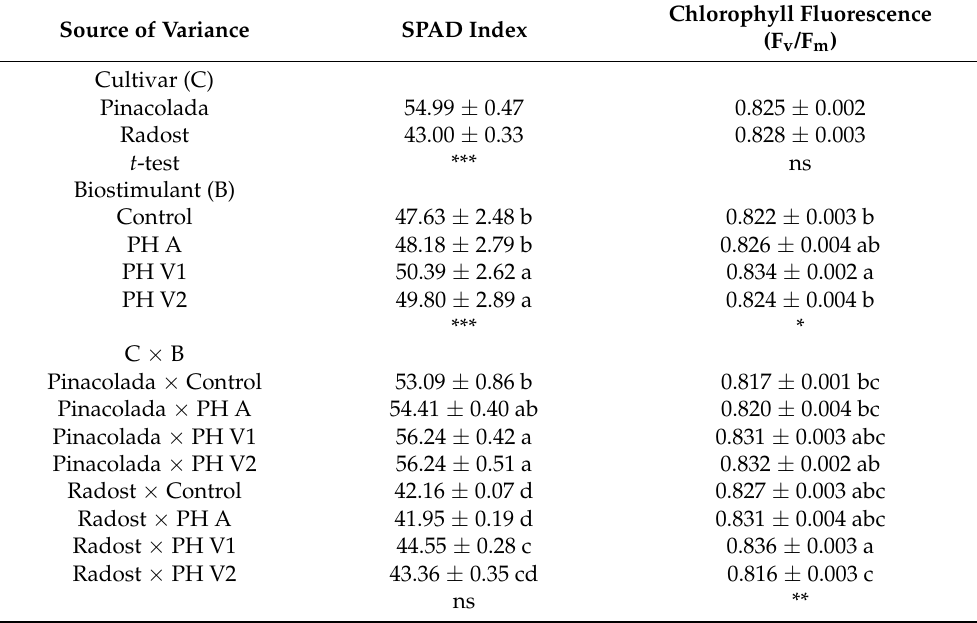
Table 3. The effect of biostimulant treatments (untreated control, one animal PH (PH A, Hicure ® ), or two vegetal PHs (PH V1, Trainer ® and PH V2; Vegamin ® )) on the SPAD index and chlorophyll fluorescence of two chrysanthemum cultivars (Pinacolada and Radost) grown under greenhouse conditions. All data are expressed as mean ± standard error; n =